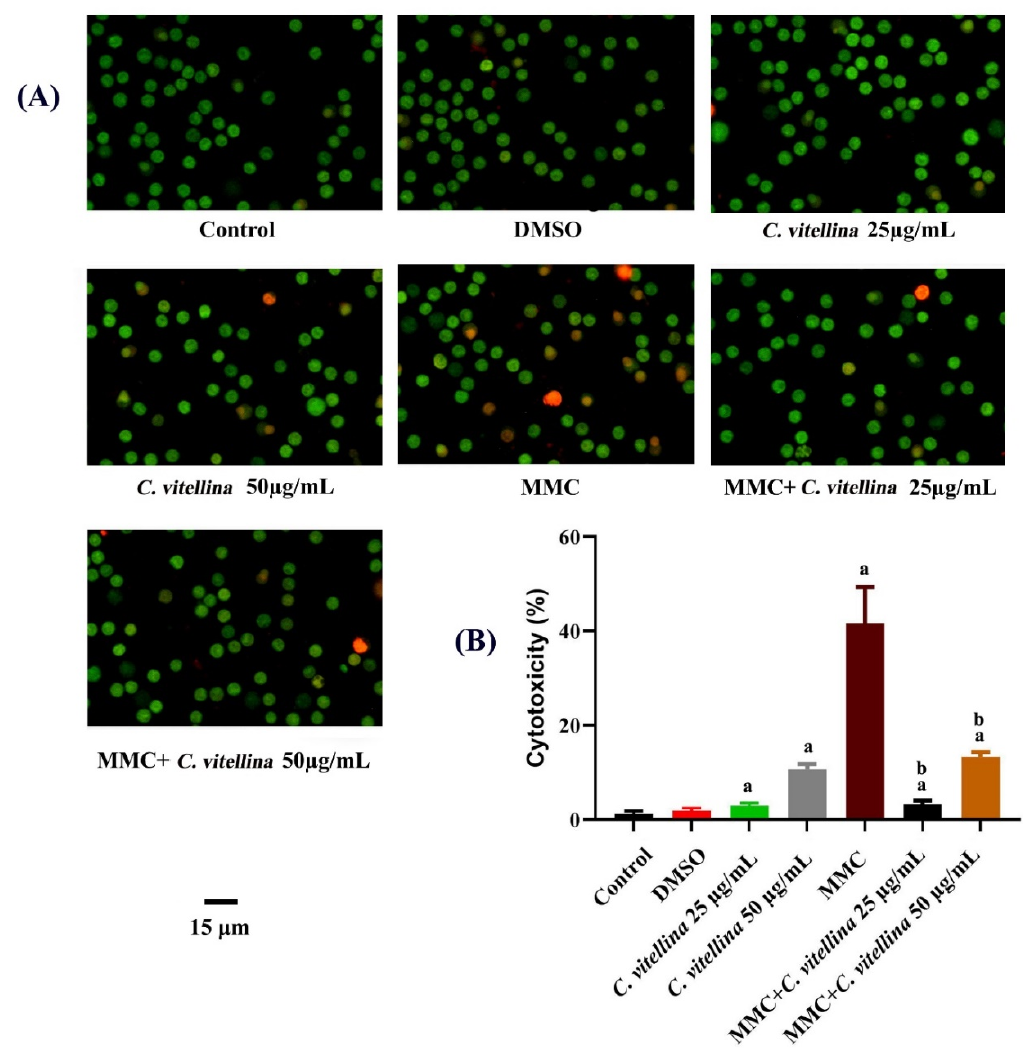
Figure 2. Photomicrographs ( A ) showing the significant ameliorative effect of C. vitellina extract on HPBL viability, 24 h against MMC toxicity, using acridine orange/ethidium bromide (AO/EB) dual fluorescent staining (Olympus BX 41 fluorescent microscope, Tokyo, Japan). Significant differences at ( P ≤ 0.05) with respect to untreated and MMC-treated groups are (a) and (b), respectively. Data were represented as (Mean ± SD) of three different experiments (n = 3), ( B ). MMC: Mitomycin C (0.5 µg/mL).